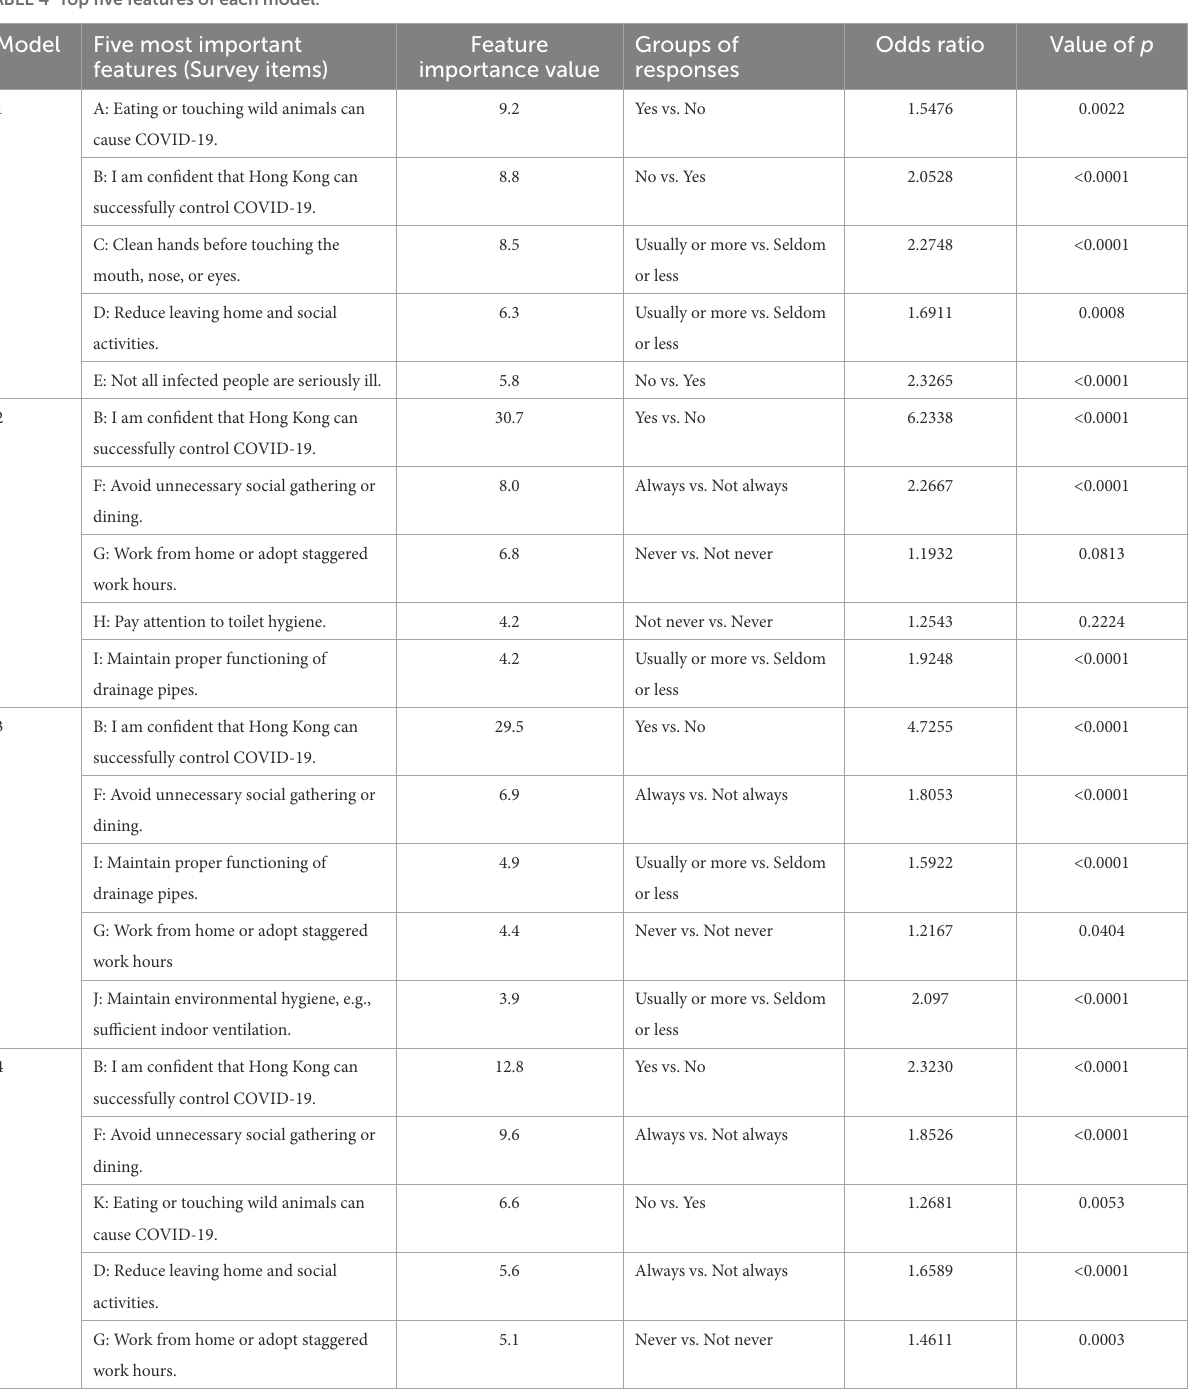
TABLE 4 Top five features of each